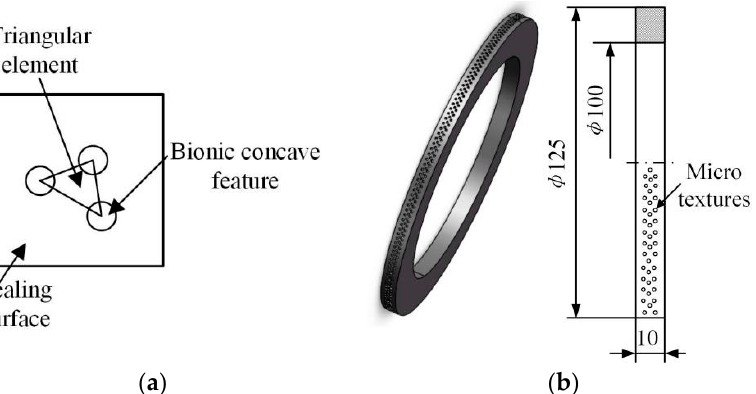
Figure 12. Bionic dimple feature of rubber sealing ring: ( a ) triangular element on the surface of the rectangular seal; ( b ) size and structure . rectangular seal; ( b ) size and